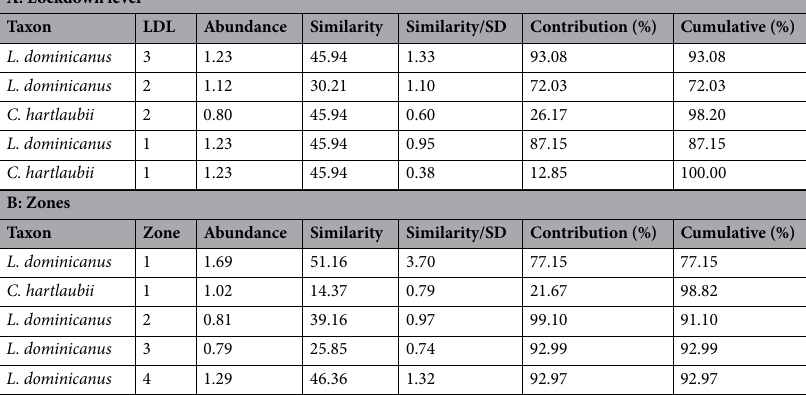
(Table 1). Based on the confluence of shorebird and human abundance curves in 2020 (Fig. 4B), we estimated that average shorebird numbers declined by 79.63% (relative to the start of lockdown level 5) with an increase in average human numbers by 34.18% (relative to the end of lockdown level 1) at the transition of lockdown level 4 to 3.